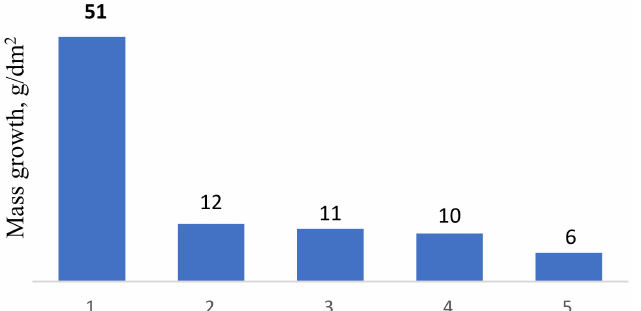
Figure 7. Heat resistance of AISI W1-7 steel (1000 ◦ C; 85 h): 1—AISI W1-7 steel; 2—Cr 7 C 3 , Cr 23 C 6 coatings; 3—titanium nitriding; 4—TiN layer with titanium aluminizing; 5—the layer of chromium carbides with titanium